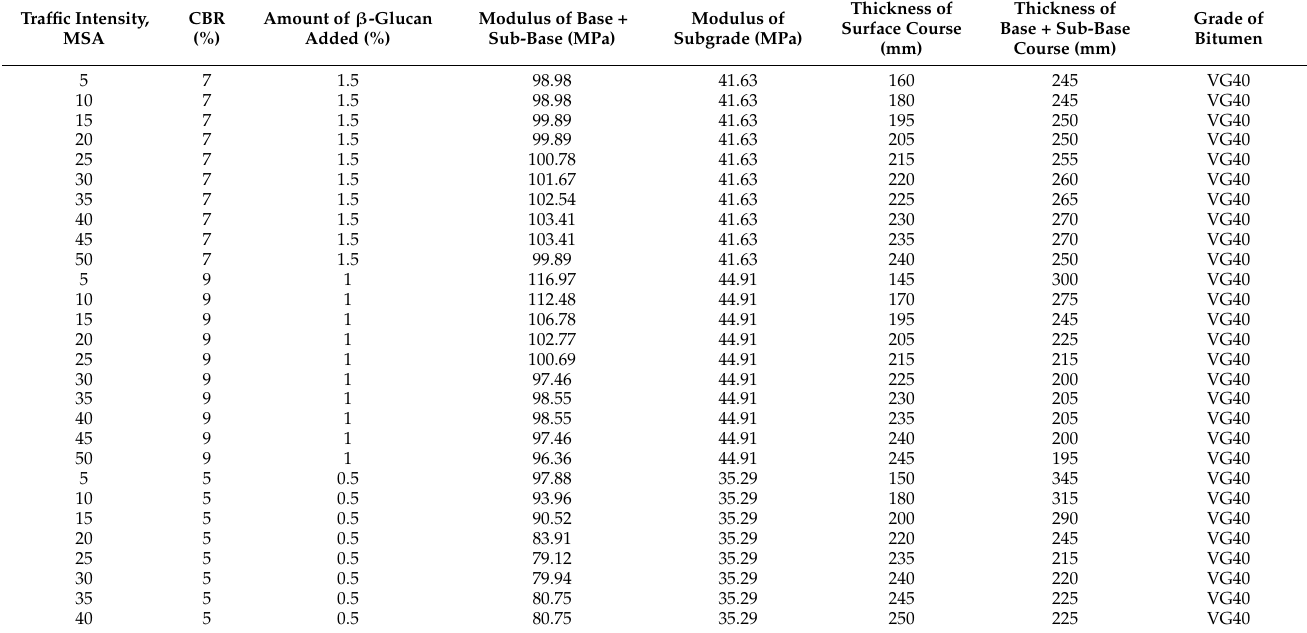
Table 3. Design thickness catalogue of β -glucan-stabilized